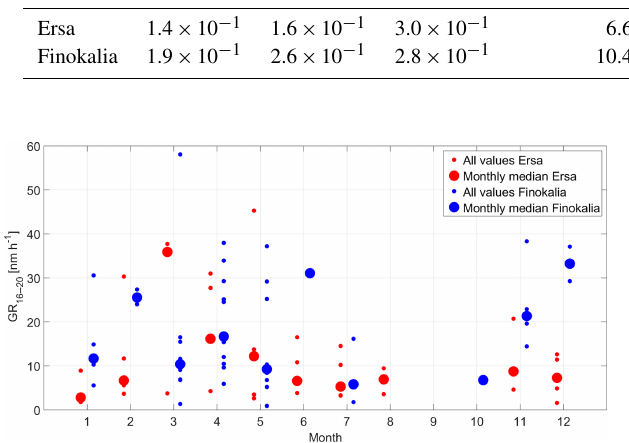
Figure 4. Annual variation of particle growth rate calculated for the range 16–20nm at Ersa and for type I events. Small dots represent all values, while large dots stand for median values.